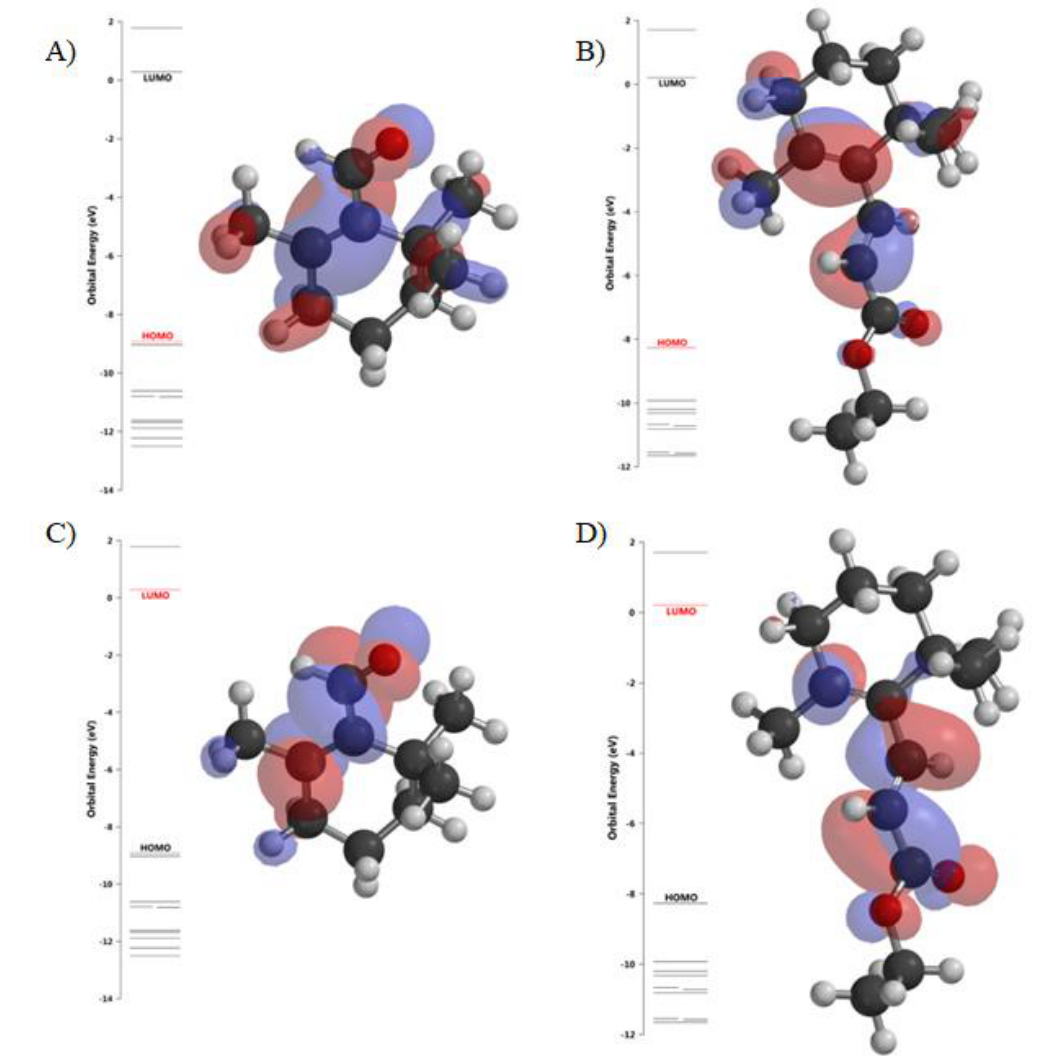
Figure 8. HOMO ( A , B ) and LUMO ( C , D ) orbitals for β-cyclocitral ( A , C ) and TMPE ( B , D ) in aqueous solution. The images were obtained using SPARTAN software.